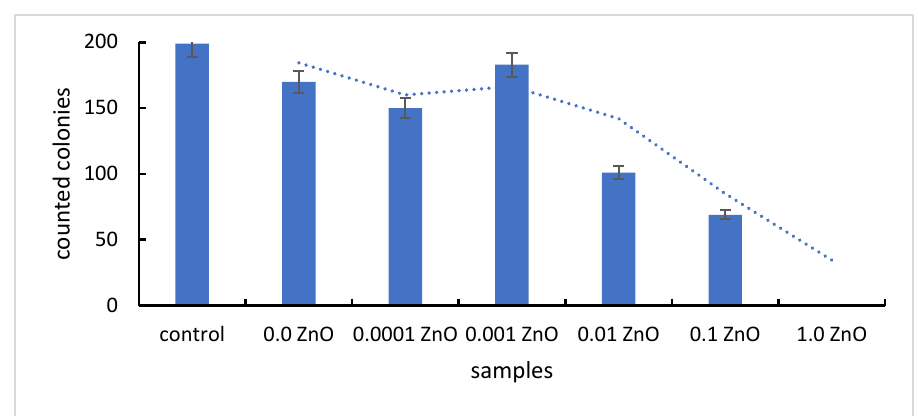
Figure 6. The colonies number evolution on the plates with various ZnO contents.